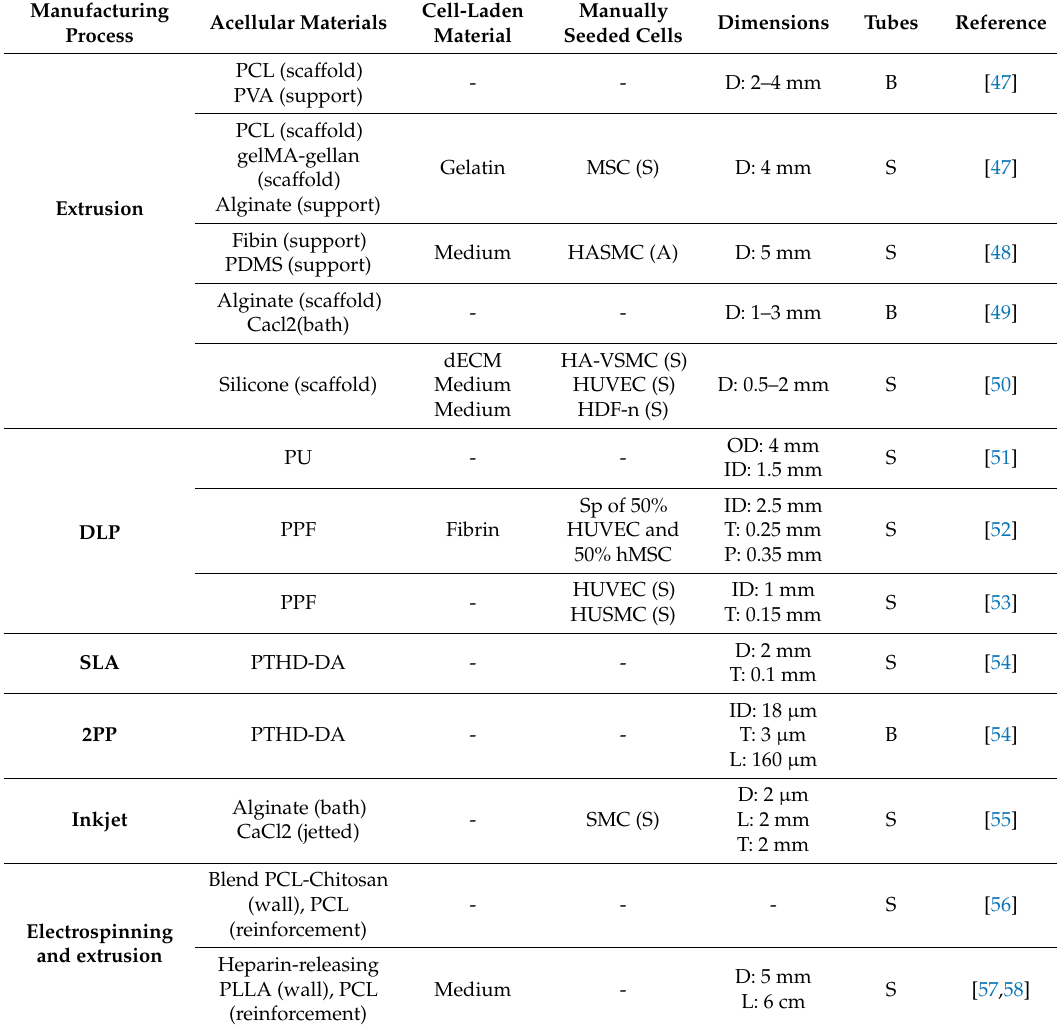
Table 1. 3D printing (acellular printing). B, Branched, S, Straight; A, aggregate, Sp, spheroids, S, cell suspension in bioink; D, Diameter, OD, outer diameter, ID, inner diameter; T, thickness, L, length, P, Pores size; MSC, Mesenchymal Stem Cell; HASMC, Human aortic smooth muscle cell; HA-VSMC, Human Aortic Vascular Smooth Muscle Cell; HUVEC, Human Umbilical Vein Endothelial Cell; HDF-n, Human Dermal Fibroblasts–neonatal; hMSC, Human Mesenchymal Stem Cell; HUVSMC, Human Umbilical Vein Smooth Muscle